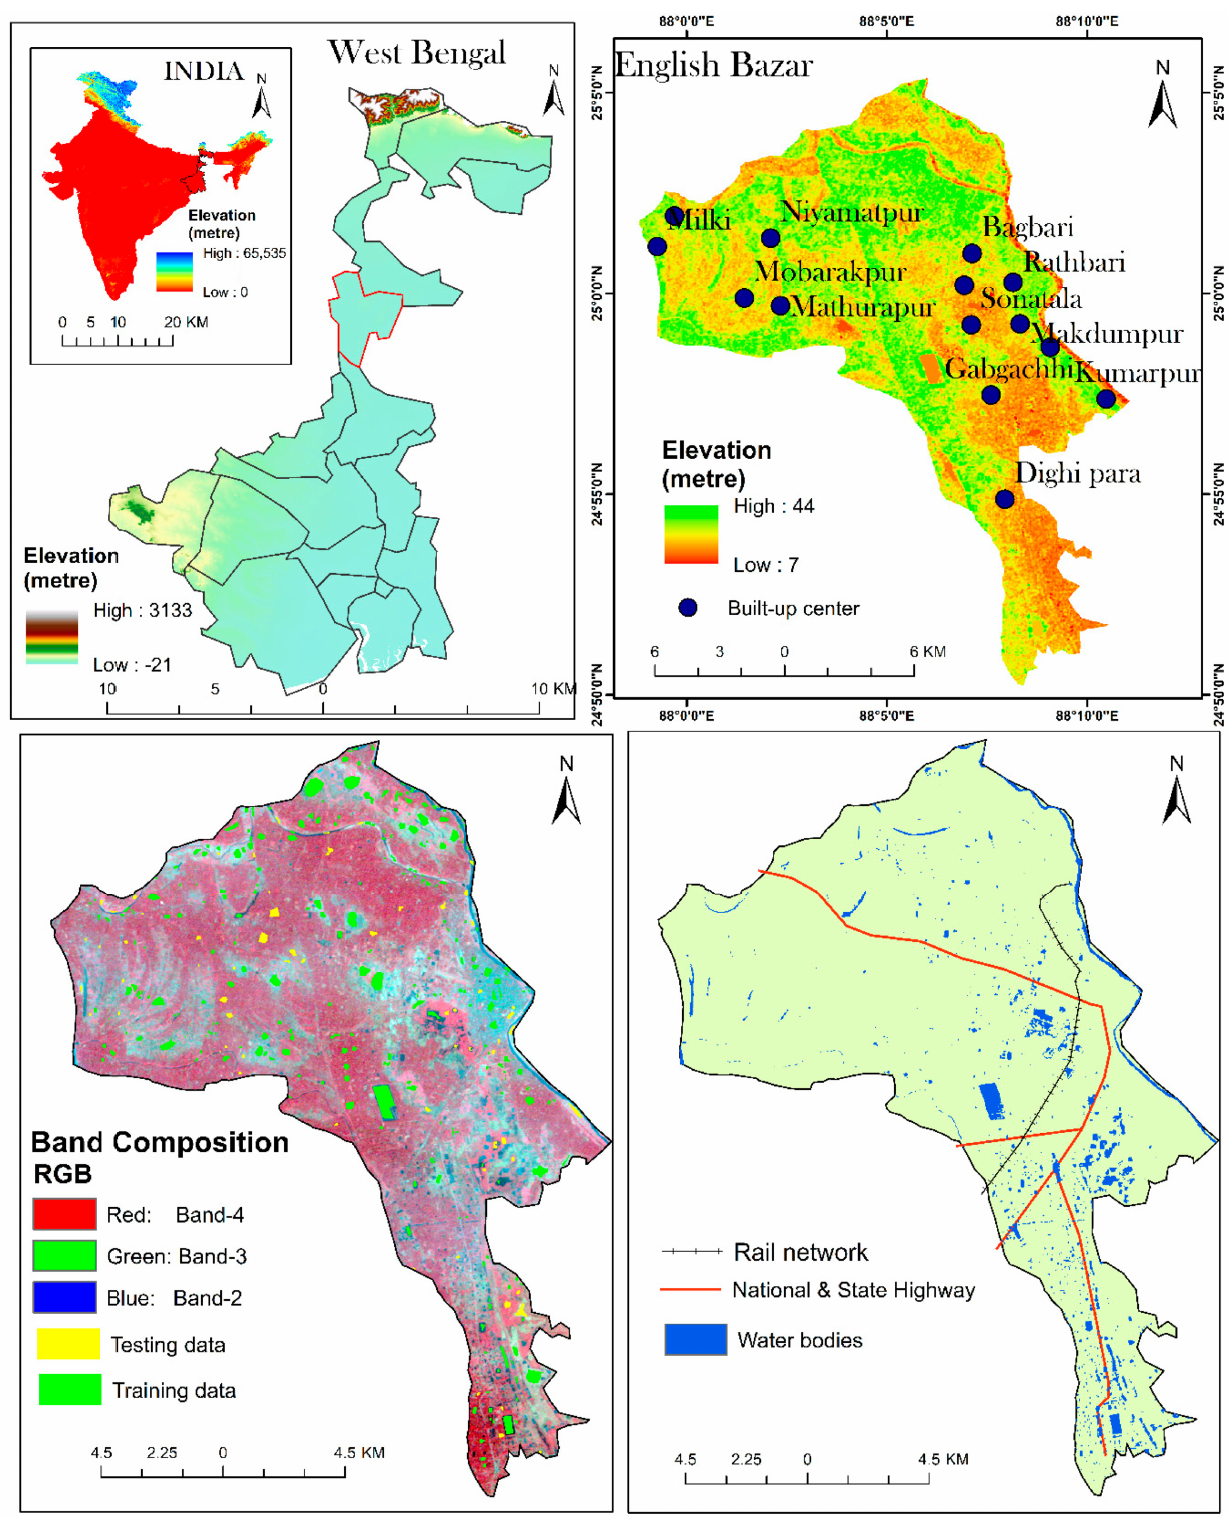
Figure 1. Location map of the study area, with the major built-up node and distribution of the training and testing